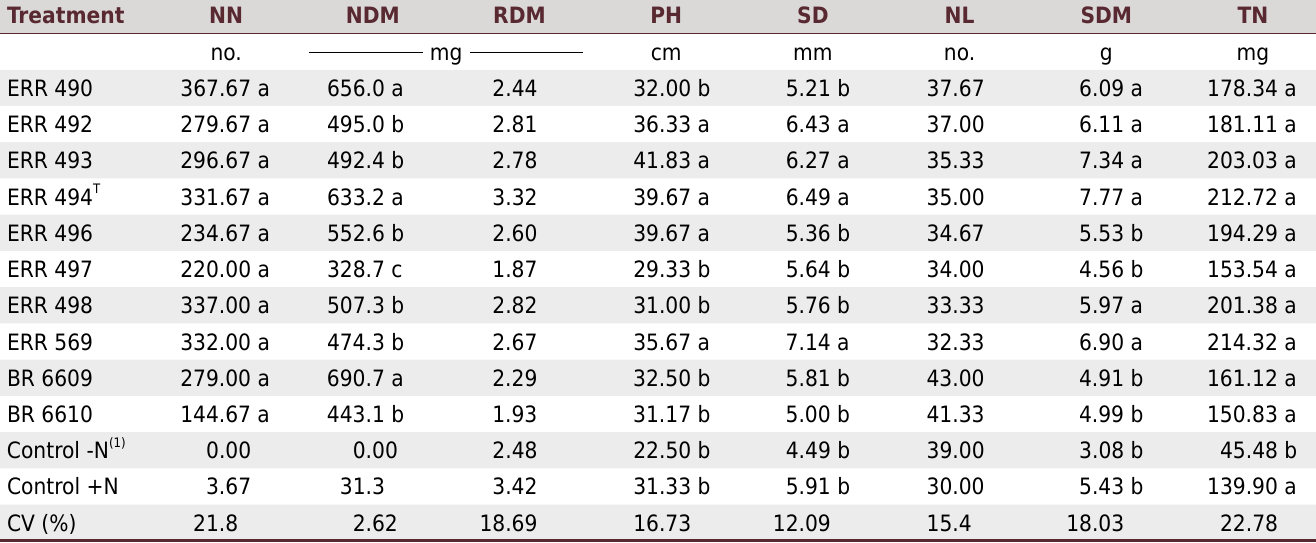
Table 1. Inga edulis Mart. response to inoculation with Bradyrhizobium ingae strains under greenhouse conditions in pots with sterile substrate for 60 days (Experiment 1)